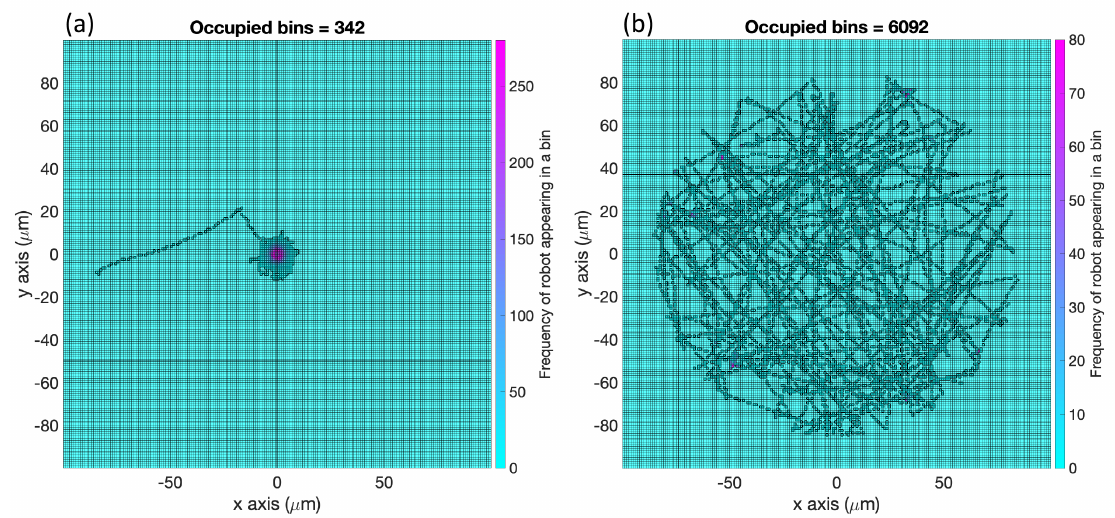
Figure 9. Explored bins are those with detected concentration that were visited. This simulation environment had one effluent concentration in the center ( 0,0 ) of the region of interest (as shown in Figure 3) and contained no obstacles. The basic chemotaxis algorithm ( a ) did not explore as much area (average percentage (AP) = 0.86%) as the RapidCell model ( b , AP =